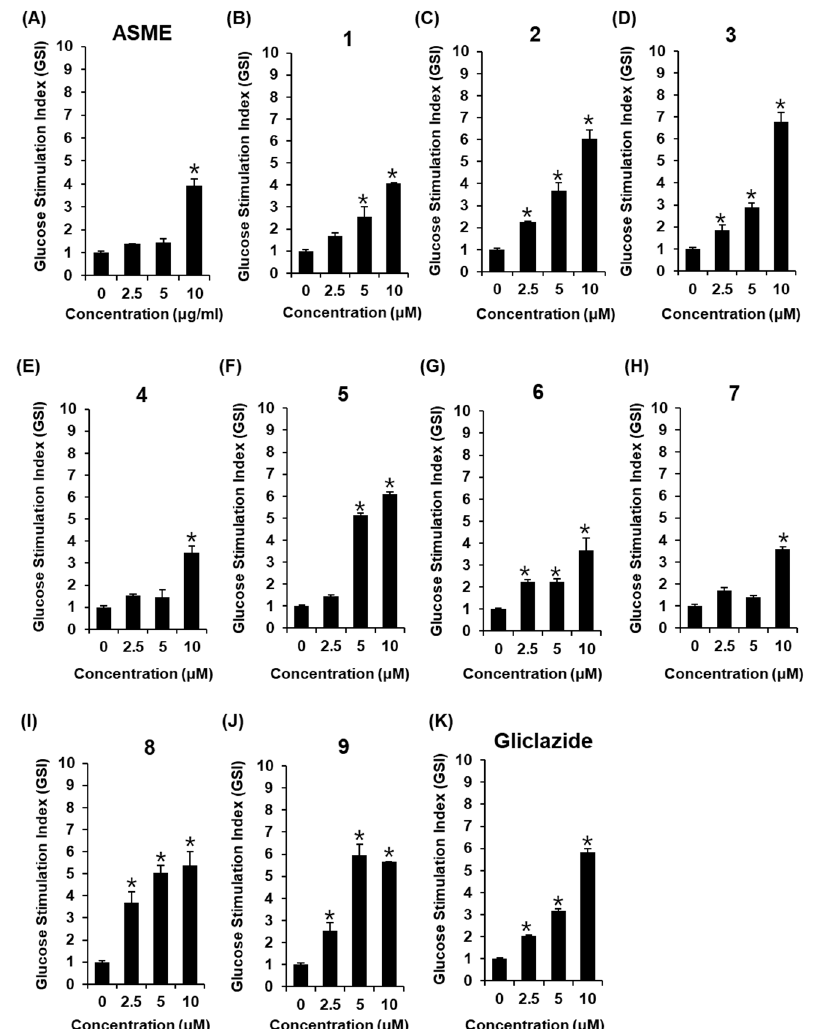
Figure 3. Effect of A. membranaceus extract (ASME) and compounds 1 – 9 isolated from A. membranaceus on glucose-stimulated insulin secretion (GSIS) in INS-1 cells. Effect of ( A ) ASME, ( B – J ) compounds 1 – 9 , and ( K ) gliclazide (positive control) on GSIS in INS-1 cells for 1 h by insulin secretion assay. * p < 0.05 compared to the control (0 μ M).